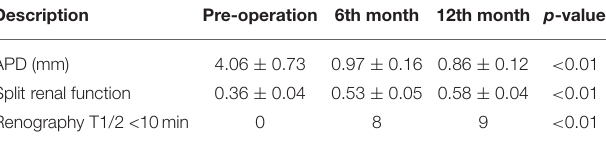
TABLE 3 | Preoperative and follow-up